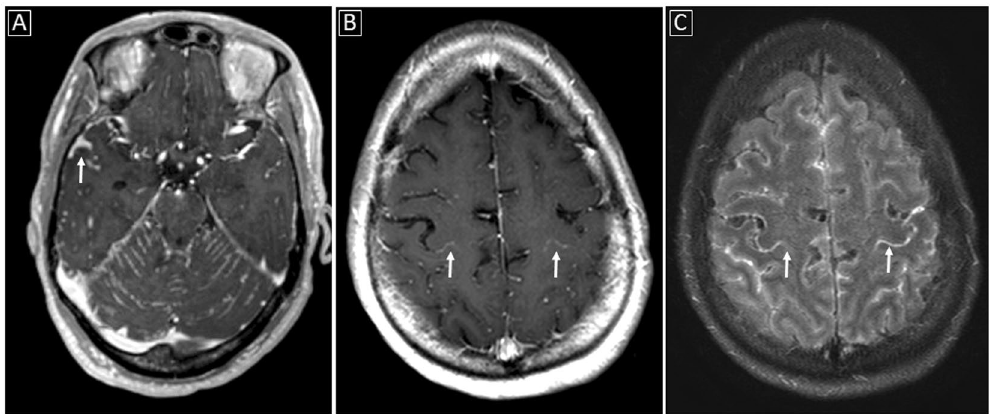
Figure 3. Examples of meningeal involvement in CNS cryptococcosis: ( A ) Abnormal meningeal enhancement along the cerebellar folia as well as along the sulci within the middle cranial fossae (white arrow) on enhanced T1-weighted image; ( B and C ) Sulcal meningeal enhancement especially delineating the central (white arrows) and postcentral sulci on enhanced T1-weighted and enhanced FLAIR images obtained near the